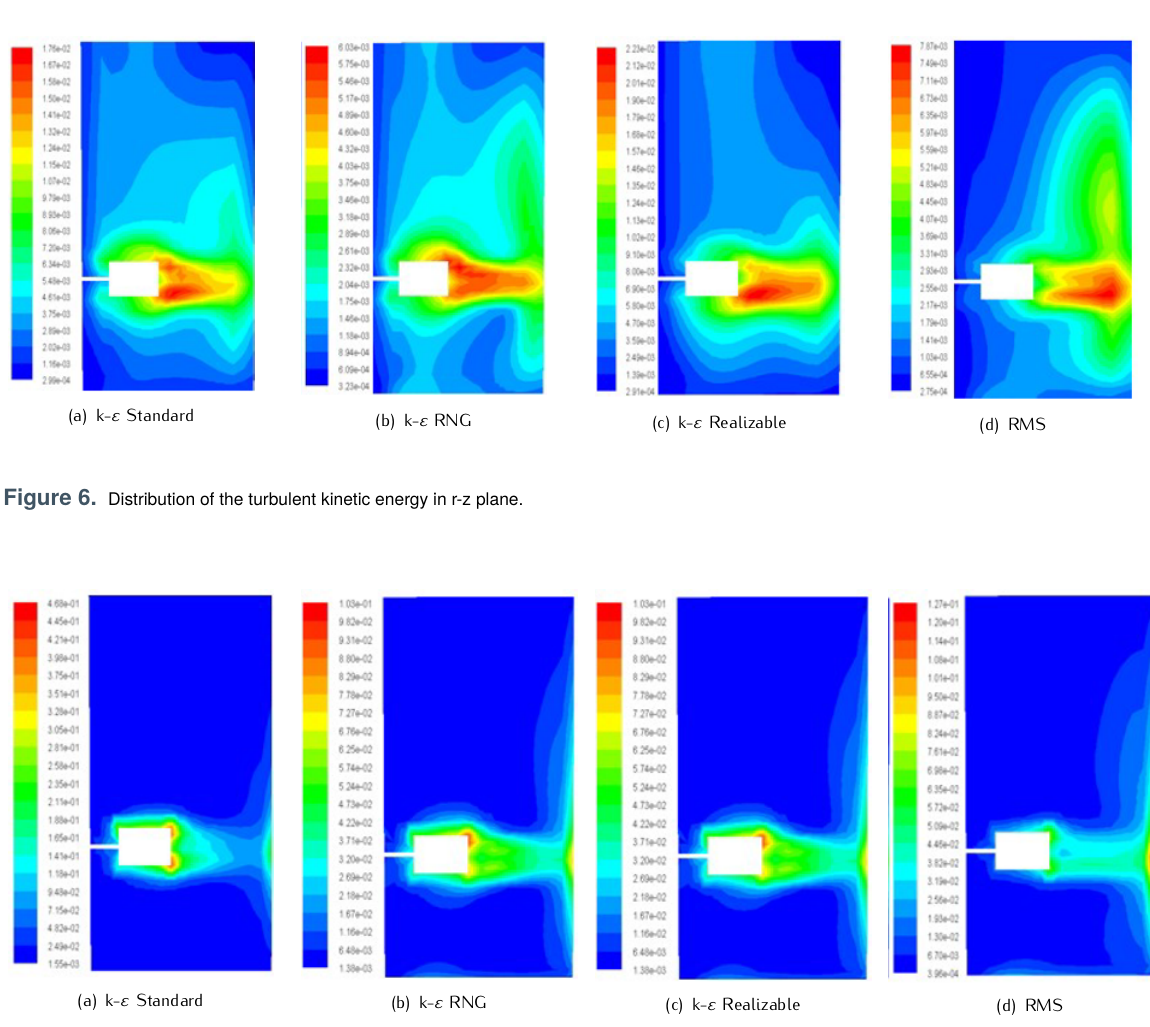
Figure 7. Distribution of the dissipation of the turbulent kinetic energy in r-z